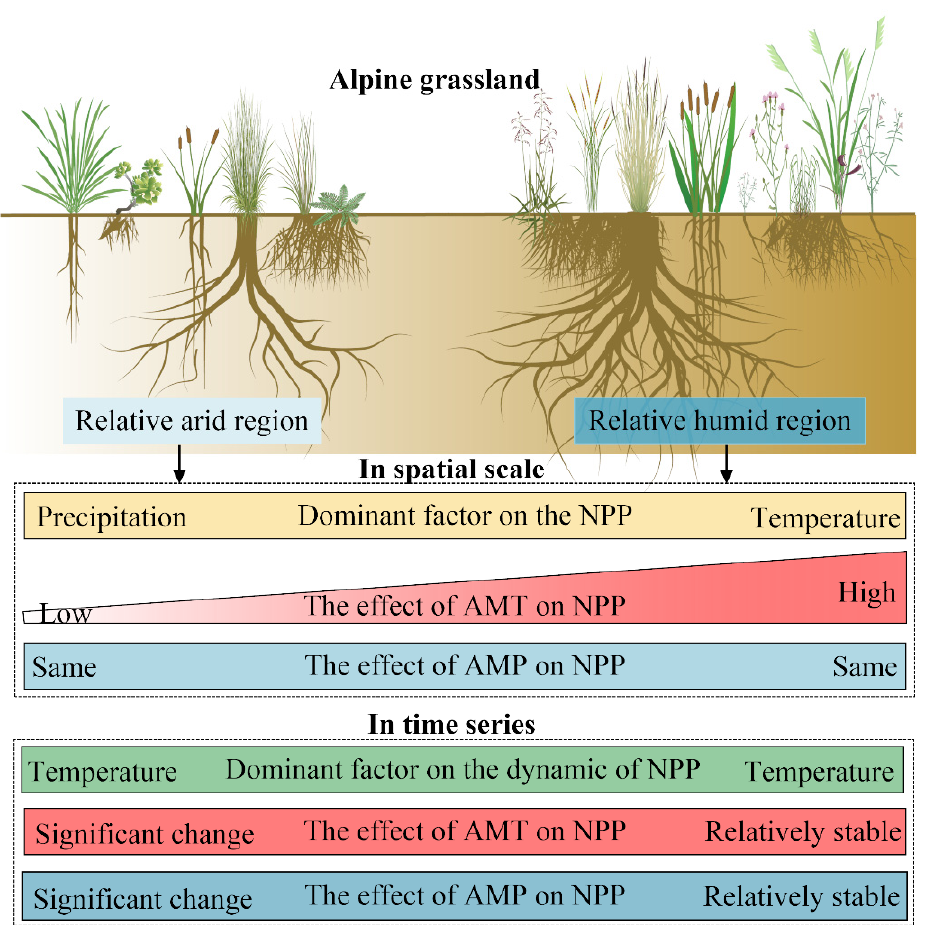
Figure 8. Summary of the conceptual model of NPP in response to the climate changes during 2001– 2019.